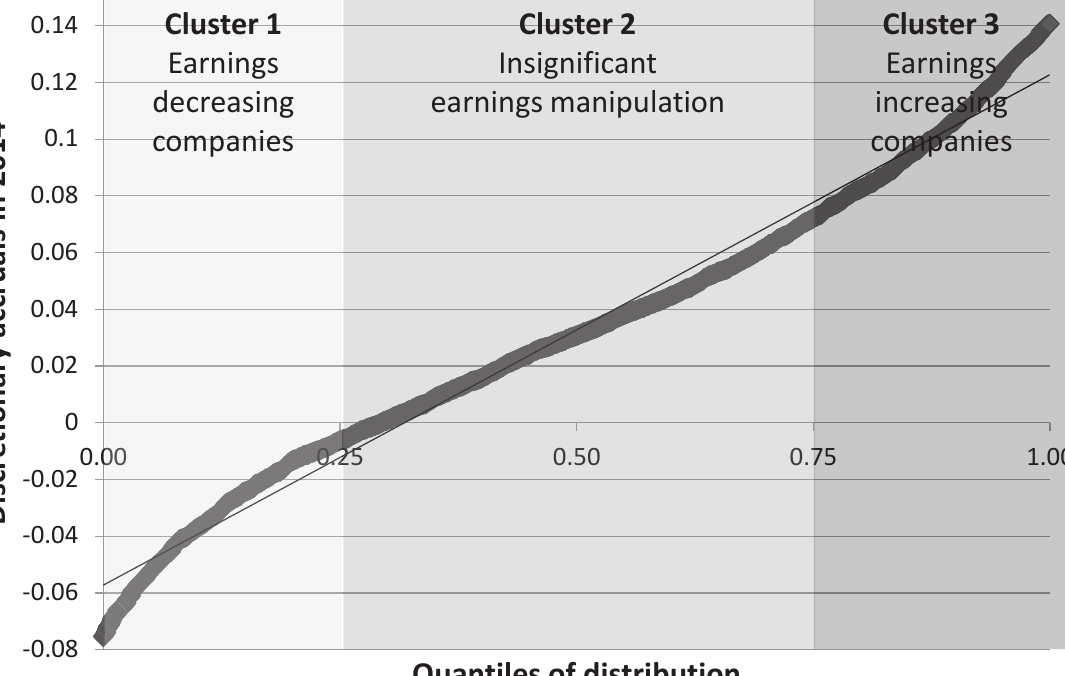
Figure 2b. Quantiles of distribution of discretionary accruals of the companies of the sample based on actual data for 2014